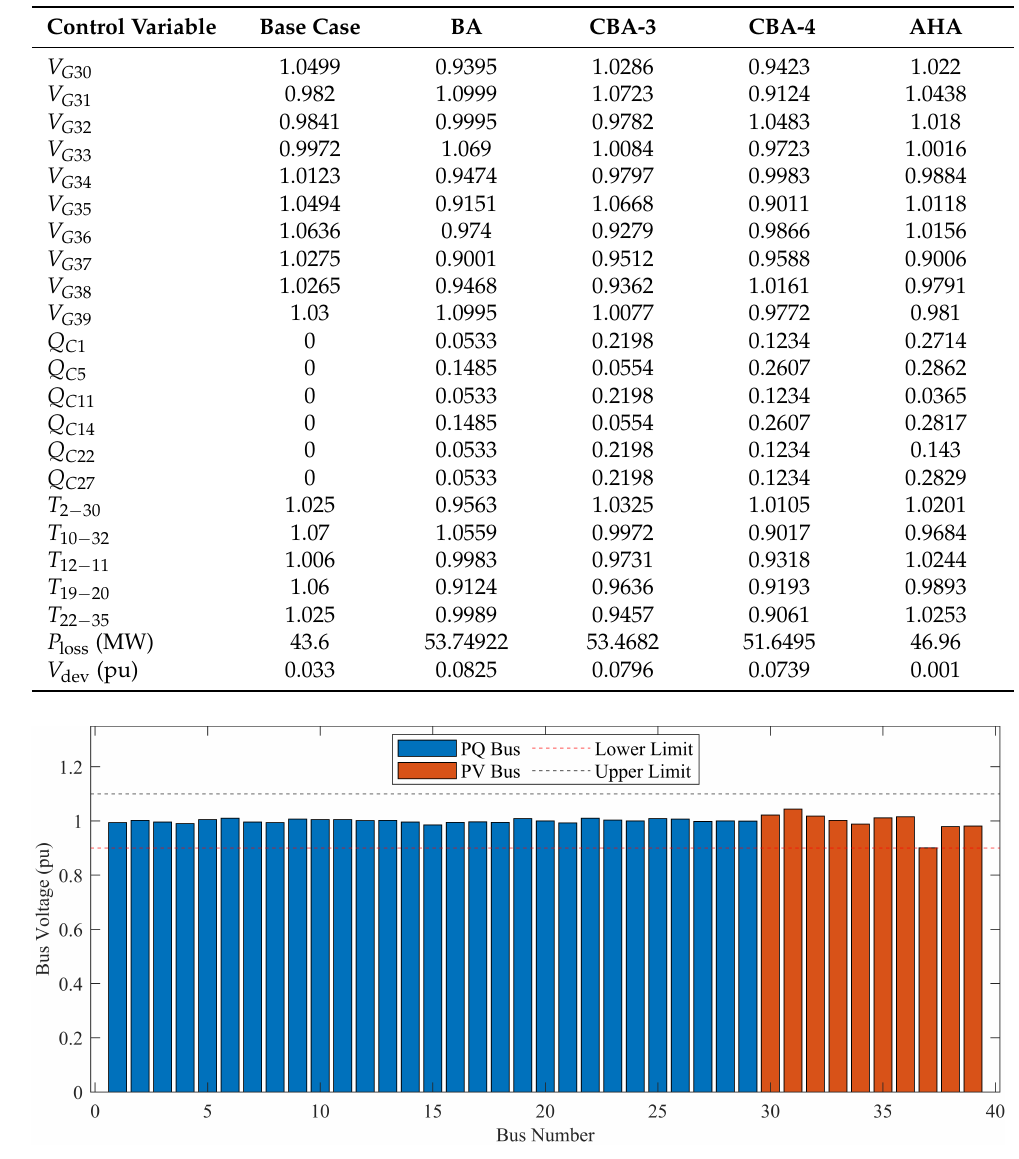
Figure 9. Bus voltages of the IEEE 39 bus power